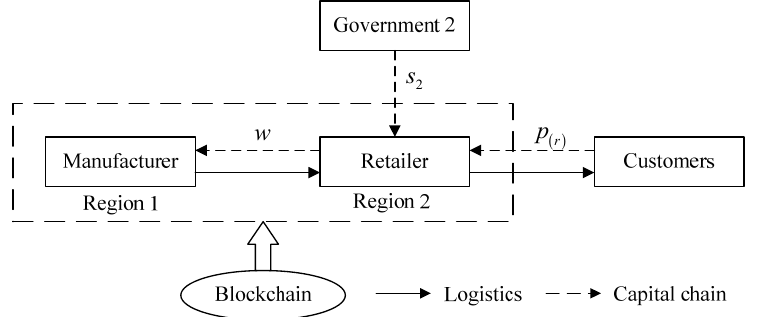
Figure 3. The structure and interaction process of FPSC system in Strategy